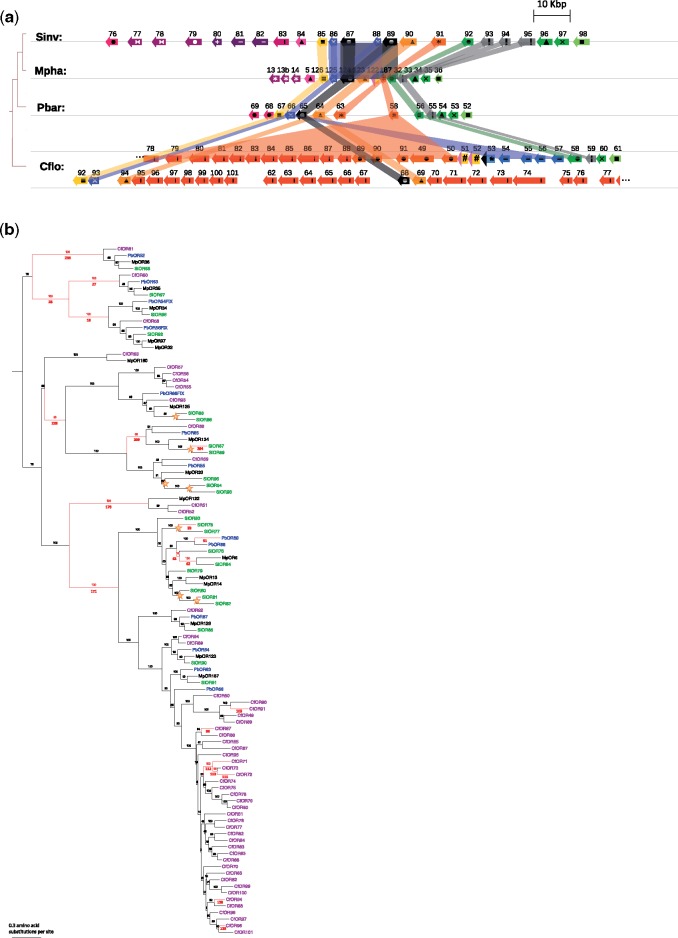
—(a) The cluster of 23 ORs on the Solenopsis invicta social chromosome and the orthologous clusters in Monomorium pharaonis, Pogonomyrmex barbatus, and Camponotus floridanus. Coloring and shading reflect orthology and gene duplications inferred from the gene tree presented in (b). Colors were chosen to indicate subgroups of closely related paralogs. Genes (arrows) and their relative genomic positions are drawn to scale. ORs were numbered independently in each species. In C. floridanus, the cluster is presented on two rows because of space limitations of the figure. (b) Subtree of the ant OR gene tree, showing the subfamily of ORs that includes the tandem cluster of 23 ORs located in the S. invicta social chromosome (gene names color coded by species). Maximum likelihood phylogeny reconstructed using RAxML, with bootstrap support shown above branches and branch numbers below. Stars mark Solenopsis-specific duplications. Branches in red indicate positive results in the branch-site test for positive selection (after FDR correction with q < 0.1).